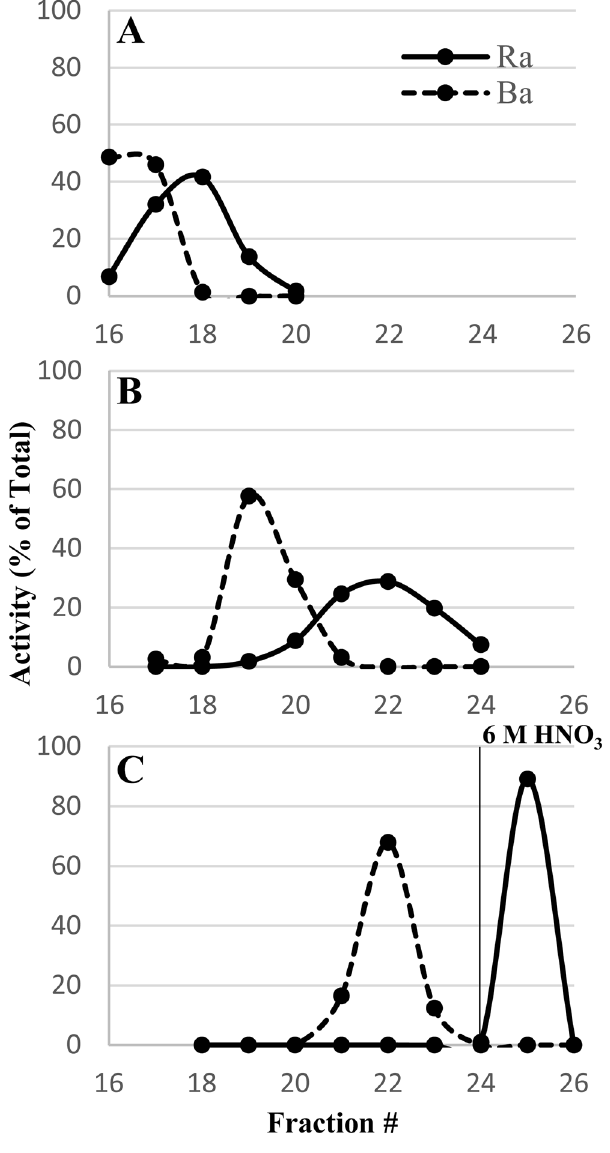
Figure 3. Cation exchange separation of radium/barium separation using 0.32 M Citrate pH 5.5 with ( A ) 1 mL, ( B ) 2 mL, and ( C ) 3 mL of AG 50WX8 resin. In C, radium was eluted with 6 M HNO 3 . Plotted lines are eye guides